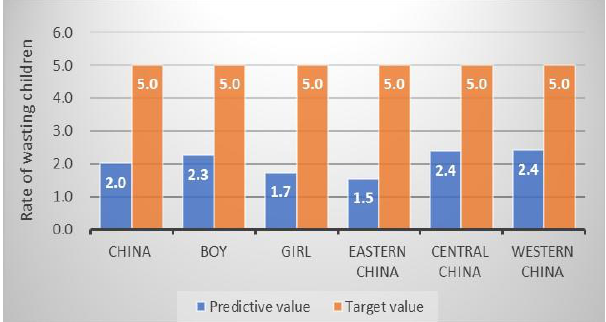
Figure 1. The estimated rate of Chinese wasting children and SDG target in 2025 (%).